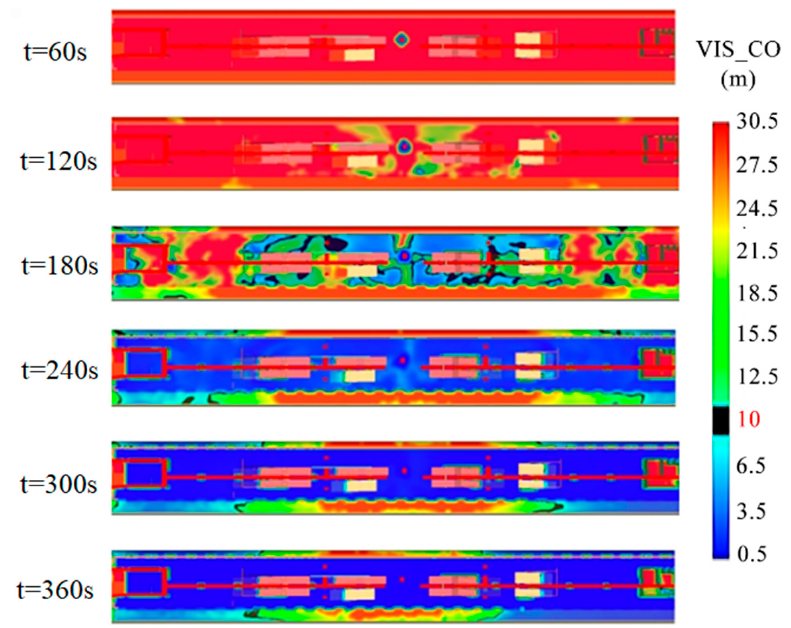
Figure 13. Visibility in the fire in the middle of the platform.